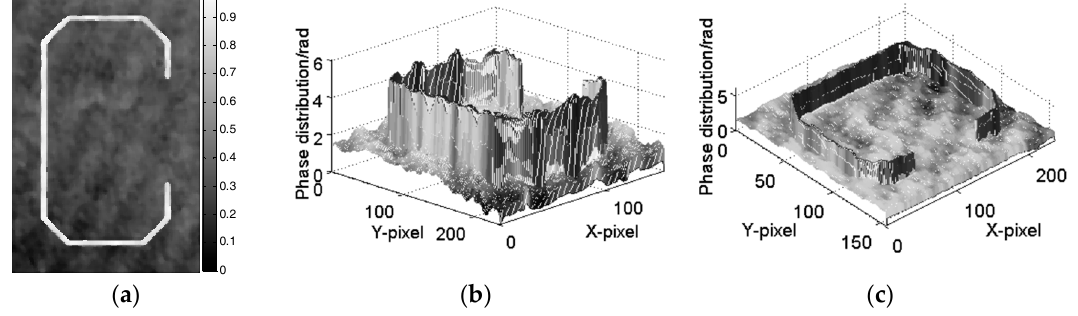
Figure 8. Phase retrieval results according to Equation (8) with A found with the proposed technique. ( a ) Retrieved phase map in grayscale; ( b ) Left view of 3D reconstructed phase distribution; ( c ) Right view of 3D reconstructed phase distribution. Adapted from Reference [18].